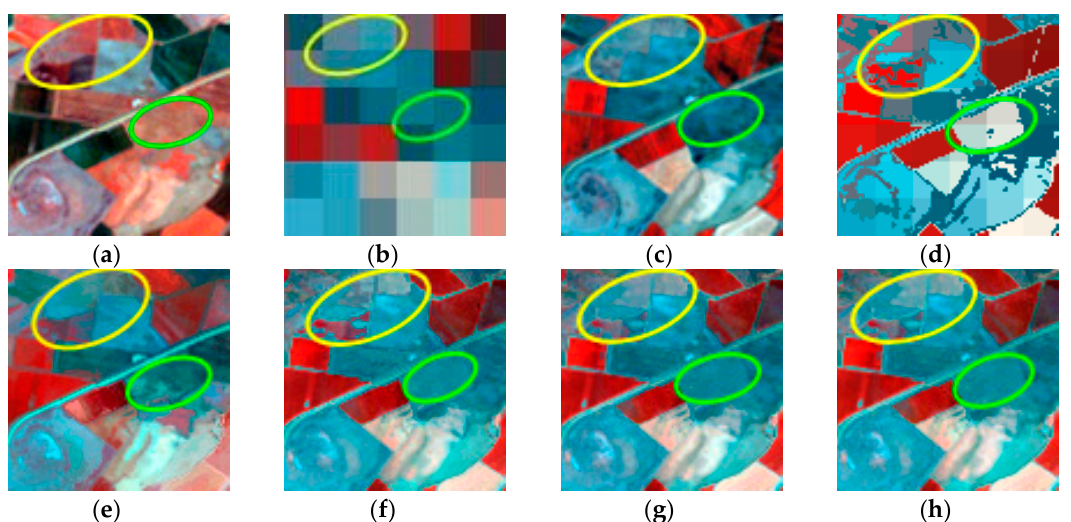
Figure 6. Magnified images in the yellow box shown in Figure 5b: original Landsat image on 25 December 2001 ( a ) original MODIS-like and Landsat images on 12 January 2002 ( b , c ), and the images predicted by UBDF ( d ), FIT-FC ( e ), FSDAF ( f ), SFSDAF ( g ) and adaptive-SFSDAF ( h ).